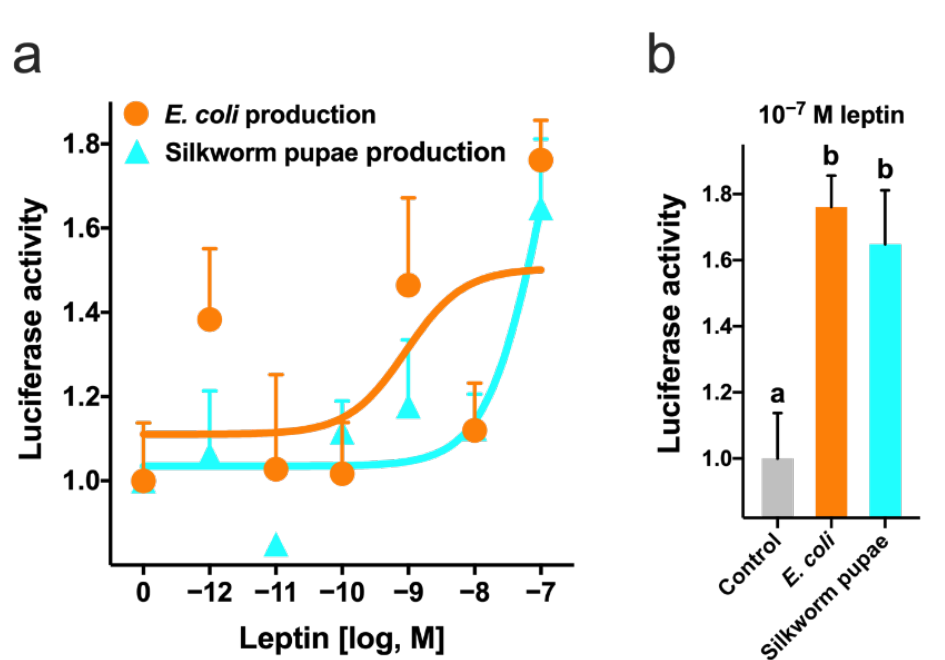
Figure 2. Receptor-binding ability of recombinant leptin produced in Escherichia coli and silkworm pupae. ( a ) LepR-transfected cells were treated with graded concentrations of leptin for 3 h. ( b ) Luciferase activity at a ligand concentration of 10 − 7 . Data represent the ratio of change in firefly luciferase activity to control Renilla luciferase activity. Each point was determined in quadruplicate and is represented as the mean ± SEM; different letters above the bars represent significant differences ( p < 0.05).